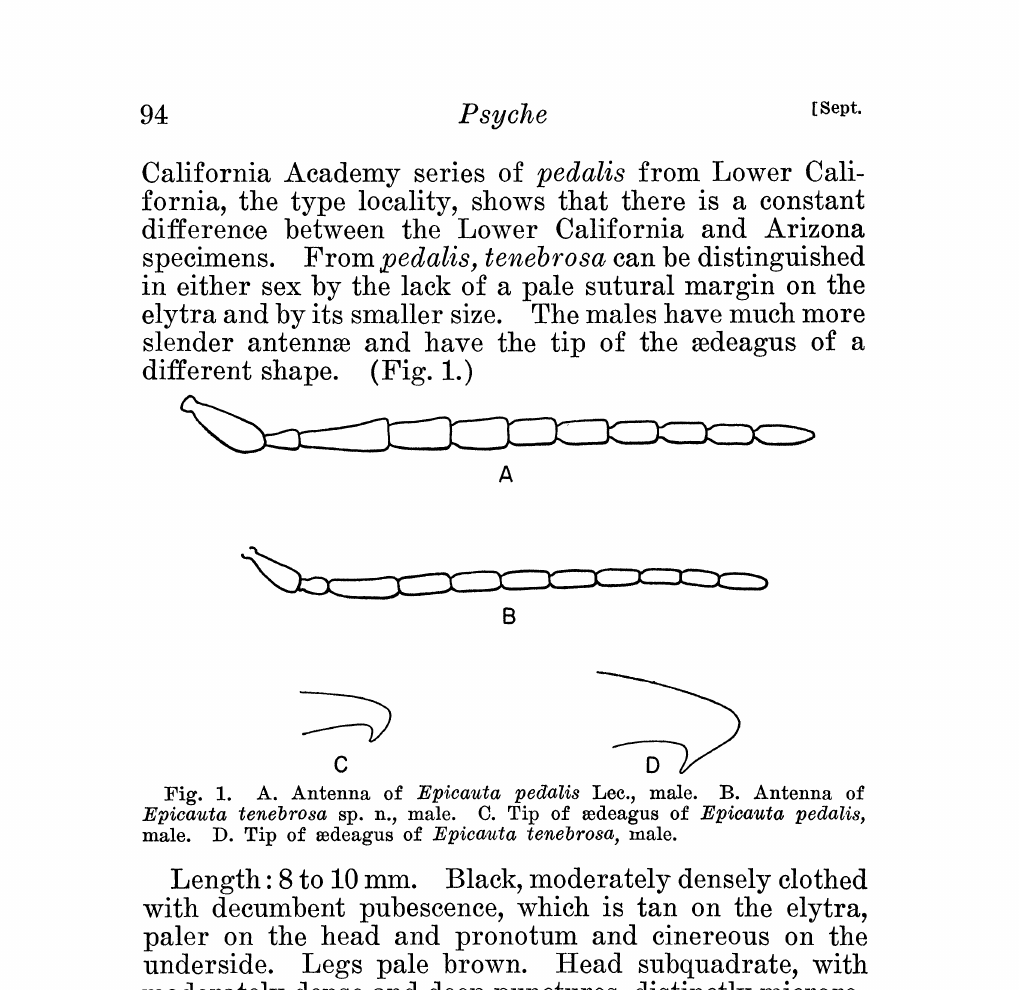
Fig. 1. A. Antenna of Epicauta pedalis Lee., male. B. Antenna of Epicauta tenebrosa sp. n., male. C. Tip of mdeagus of Epicauta pedalis, male. D. Tip of edeagus of Epicauta tenebrosa,